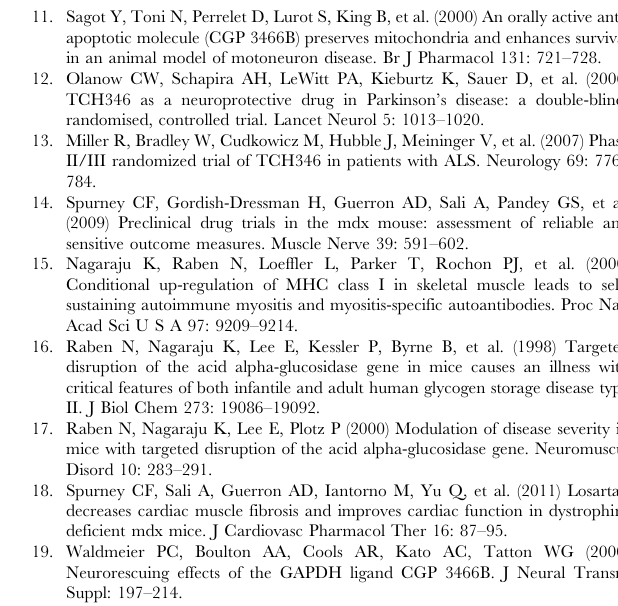
Figure S1 Longitudinal functional test data for groups with mean and standard deviation for BL6 and dy 2J (vehicle, 0.1 mg/kg omigapil and 1 mg/kg omigapil) mice across the protocol time points: baseline; after 10 weeks of treatment with omigapil; after 4 week washout period; and after 3.5 weeks of retreatment with omigapil. Figure S2 Individual mouse functional test data and age measured for BL6 and dy 2J (vehicle, 0.1 mg/kg omiga- pil, 1 mg/kg omigapil) mice during the main protocol time periods: baseline; after 10 weeks of treatment with omigapil; after 4 week washout period; and after 3.5 weeks of retreatment with omigapil. Table S1 Analysis of outcome measure values as a percentage of mean wild type values in 30-33 week old omigapil and vehicle treated dy2J mice showing signifi- cance in respiratory rate and fibrosis.